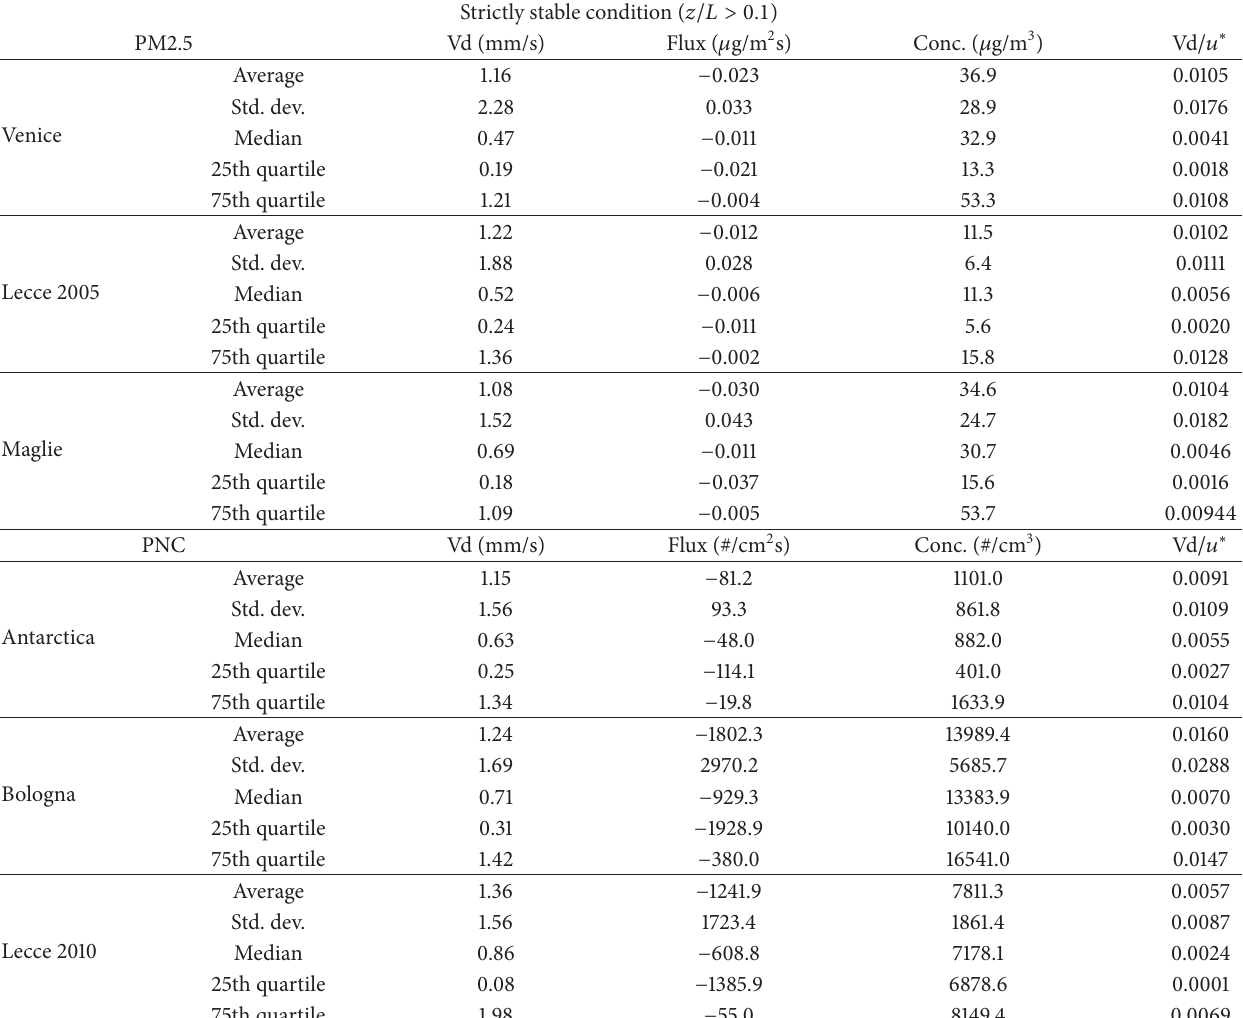
Table 6: Average (with standard deviation) and median (with 25th and 75th quartiles) values are reported for deposition velocities, fluxes, concentrations, and normalized deposition velocities for each site, separating PM2.5 from particle number data. In this table data is selected for strictly stable atmospheric stability cases 𝑧/𝐿 > 0.1